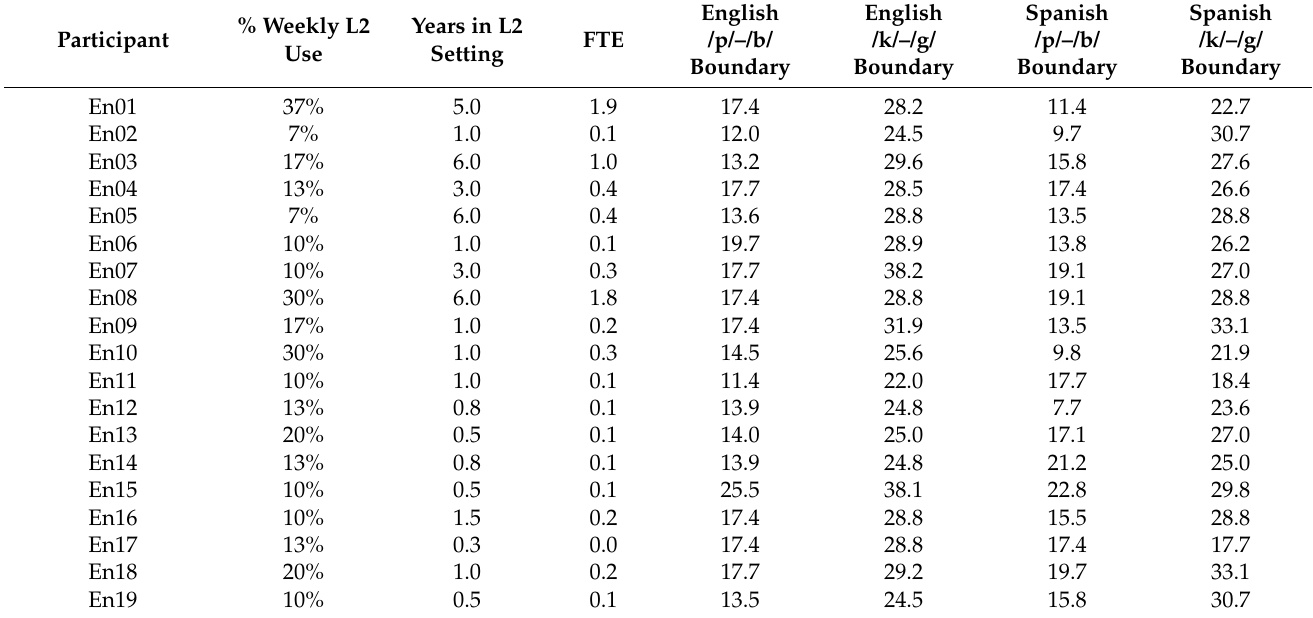
Table 2. Percentage of L2 use, years spent in an L2 setting, FTE and the category boundaries for the bilabial and velar contrasts in English and Spanish by the English learners of Spanish.